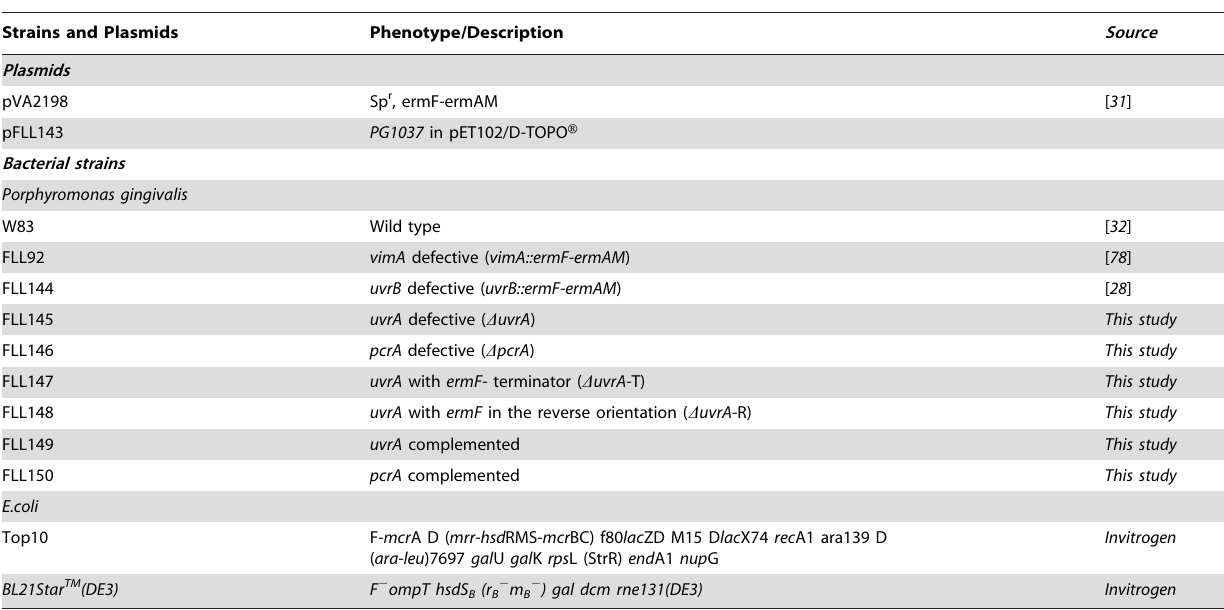
Table 1. Plasmids and bacterial strains used in this study.